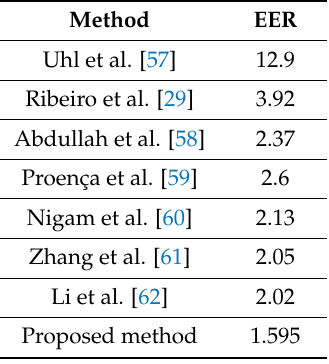
Table 8. Comparative EERs on CASIA-Iris-Lamp database (unit: %).